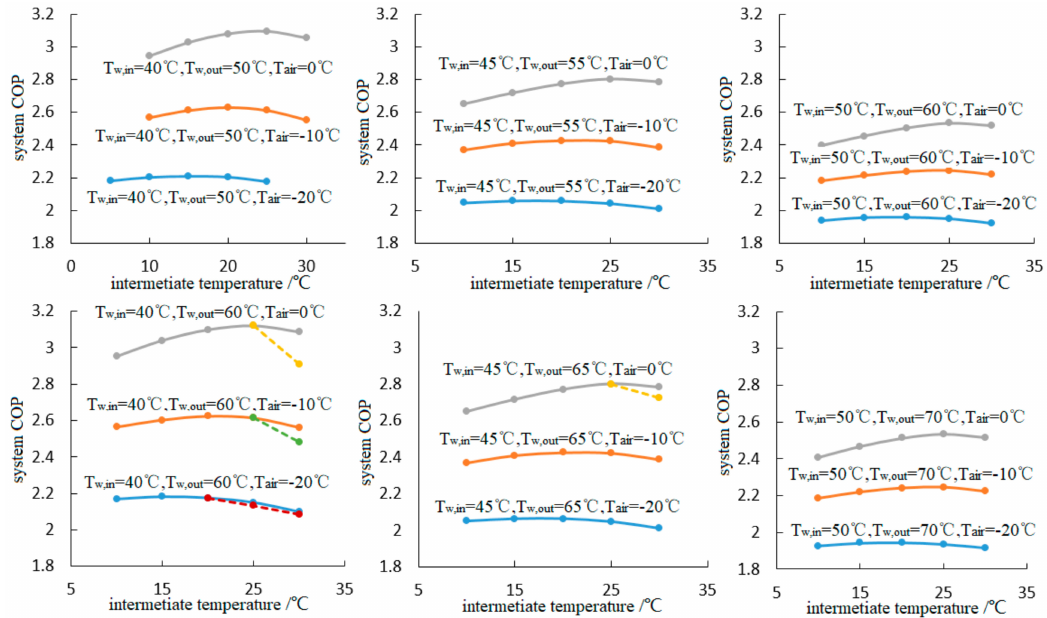
Figure 4. The system coe ffi cient of performance (COP) versus the intermediate